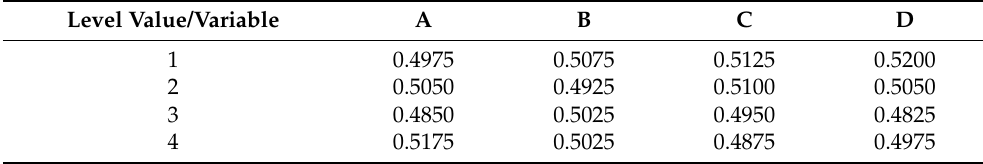
Table 9. Mean value of torque for each variable at the level factor.